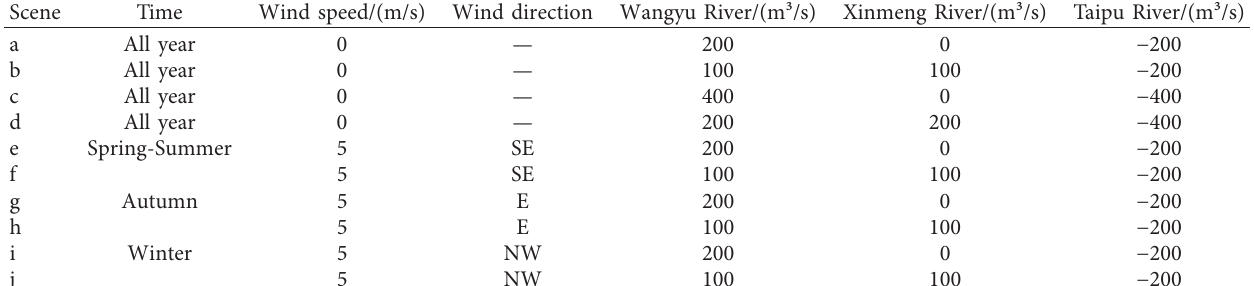
Table 2: Simulated operating mode under different water diversion and hydrological conditions.